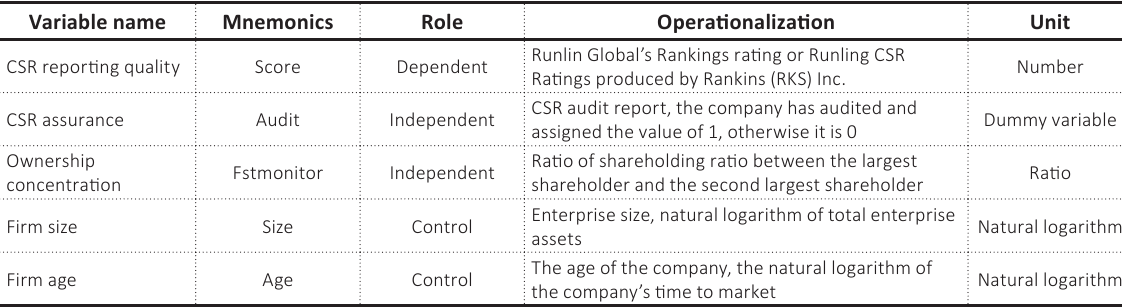
Table A2. Description of variables used in the